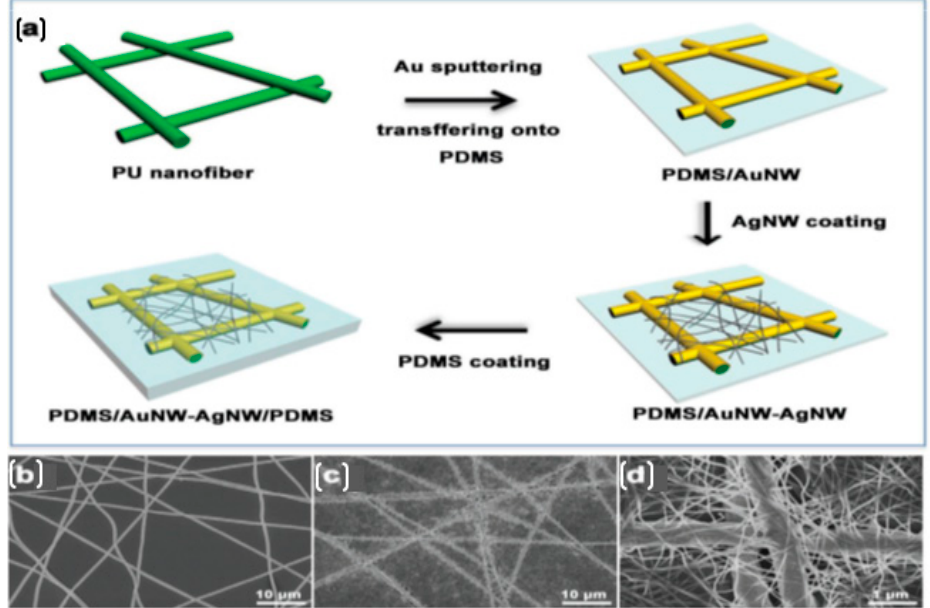
Figure 7. ( a ) Schematic illustrations of stretchable AgNW-AuNW/PDMS composite fabrication steps. Top-view EM images of ( b ) AuNWs and ( c – d ) AuNW–AgNW hybrid networks on PDMS substrate. Reprinted with permission from Ref. [76]. Copyright 2018, Wiley Online Library.